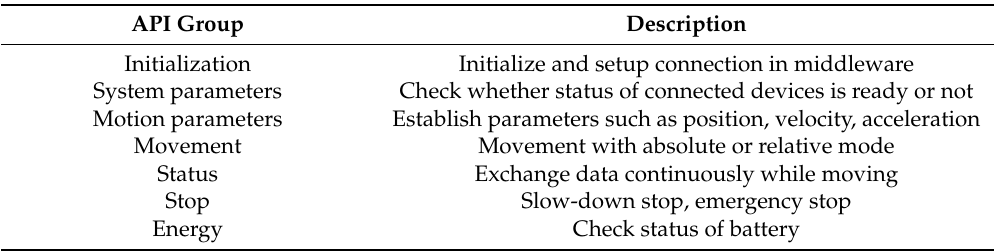
Table 2. List of API function groups.